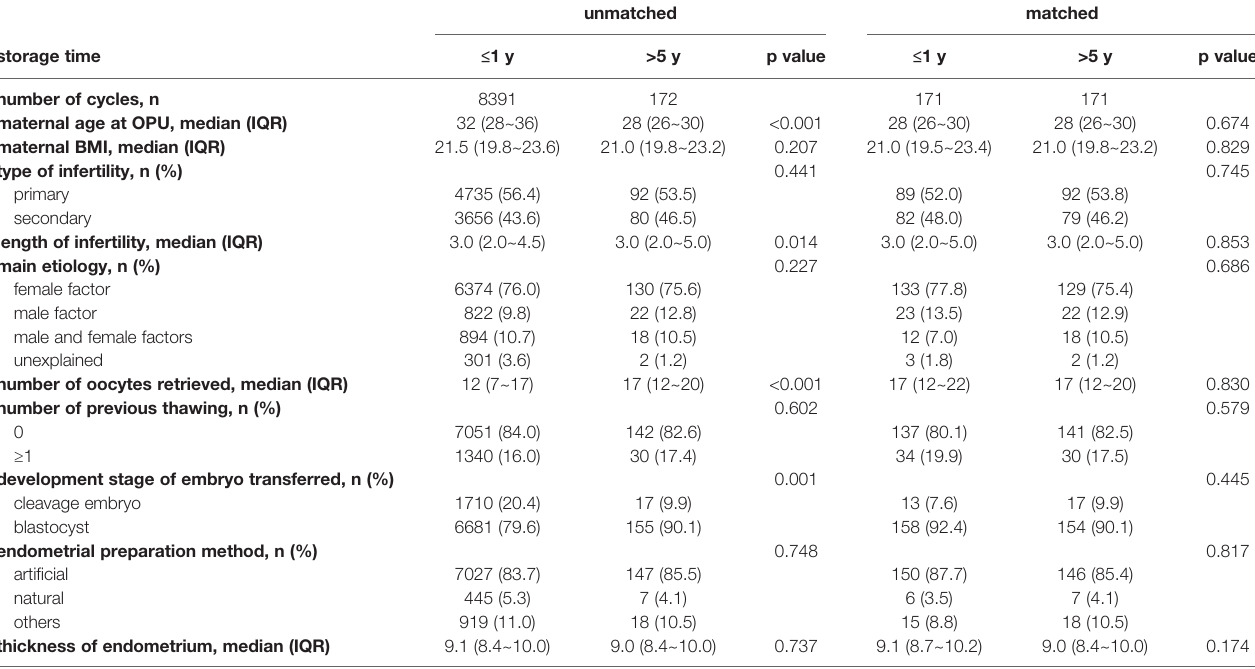
TABLE 5 | Baseline characteristic of cycles with storage time ≤ 1 year and >5 years before and after matching.